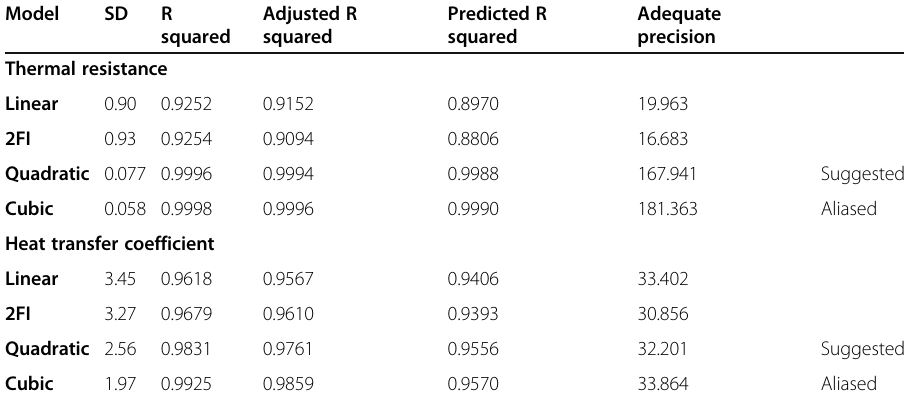
Table 2 Model summary of